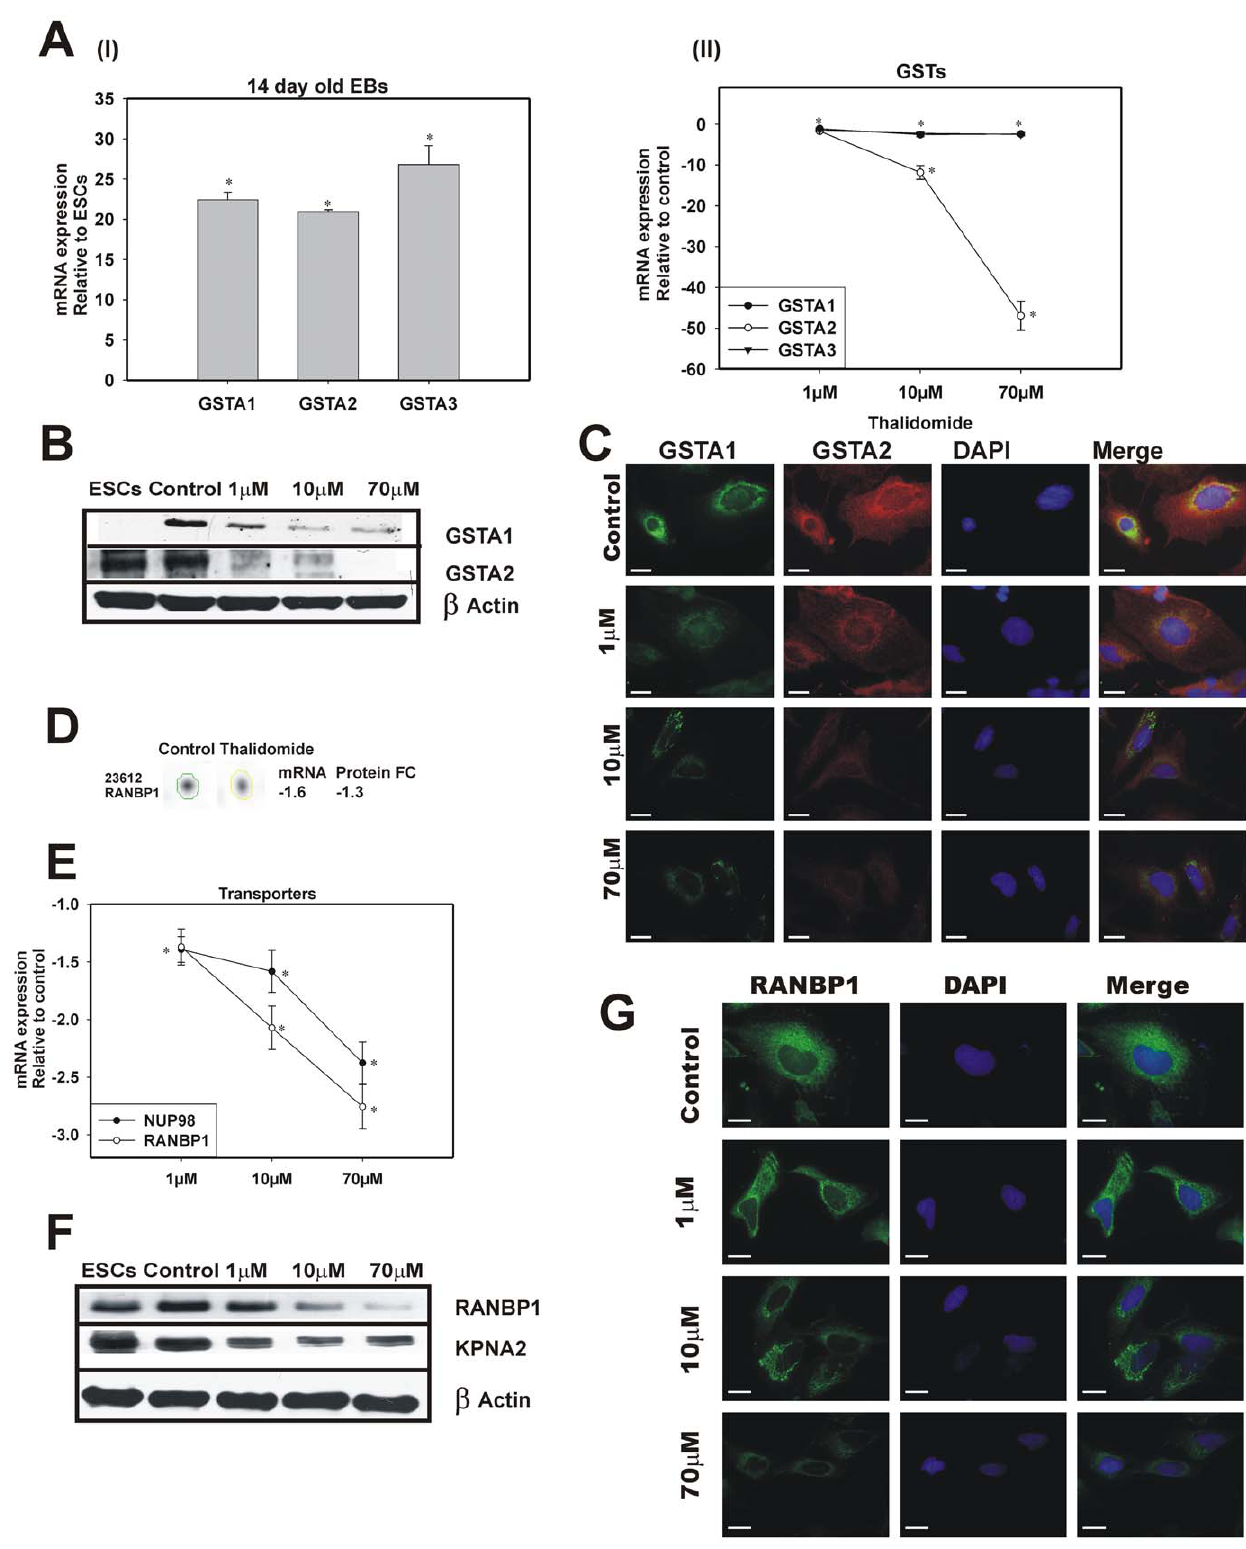
Figure 5. Thalidomide suppressed the GST genes and nucleocytoplasmic transporters at mRNA and protein level. To validate microarray expression. A , (I) (RT-qPCR analysis) 14 day’s hESC differentiation showed higher GST expression (*p-value # 0.01, 14 days old EBs vs ESCs) and (II) thalidomide treatment (**p-value # 0.05, thalidomide-treated vs untreated 14-days old EBs) repressed GST genes more than 2 2 fold change. The error bars represent the SEM from 3 technical replicates from an independent experiment. B , Immunoblotting analysis of GSTA1/2 confirms thalidomide induced perturbation at protein concentration. C , The cellular localisation of GSTA1/2 showed pronounced concentration of GSTA on